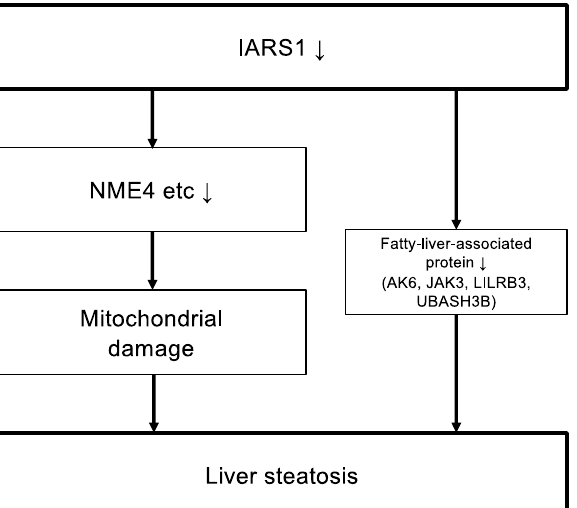
Figure 6. The proposed mechanism of mitochondrial damage and pathogenesis of fatty liver in IARS hypofunction. The downregulation of various mitochondria-associated proteins, including NME4, caused by IARS hypofunction leads to mitochondrial injury and subsequent development of fatty liver. Alternatively, IARS hypofunction may directly contribute to the pathogenesis of fatty liver by downregulating proteins involved in hepatic lipid metabolism, such as AK6, JAK3, LILRB3, and UBASH3B. The arrows ( ↓ ) indicate downregulation of protein expression.